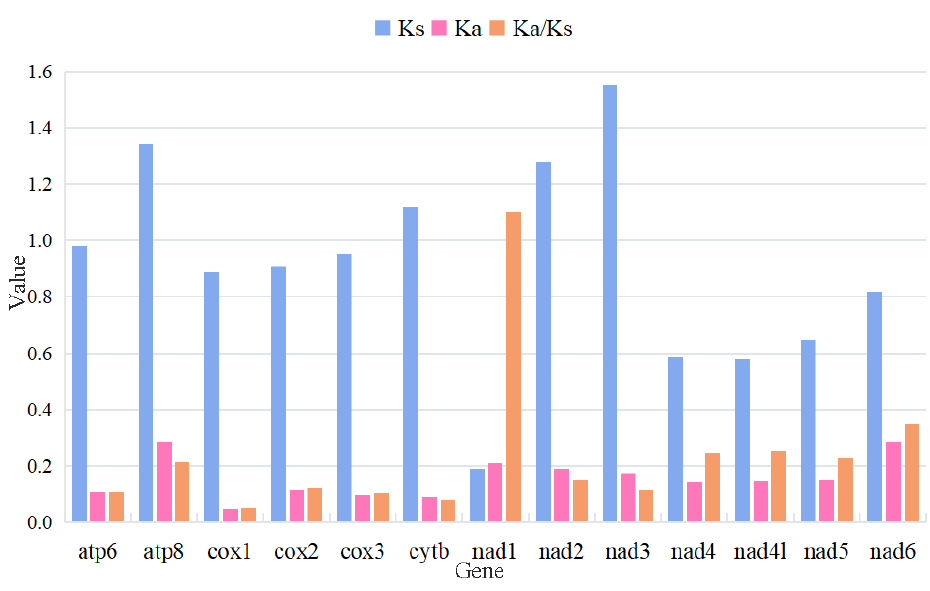
Figure 4. Nucleotide diversity (Pi) of 13 PCGs in three newly sequenced buprestid mitogenomes.